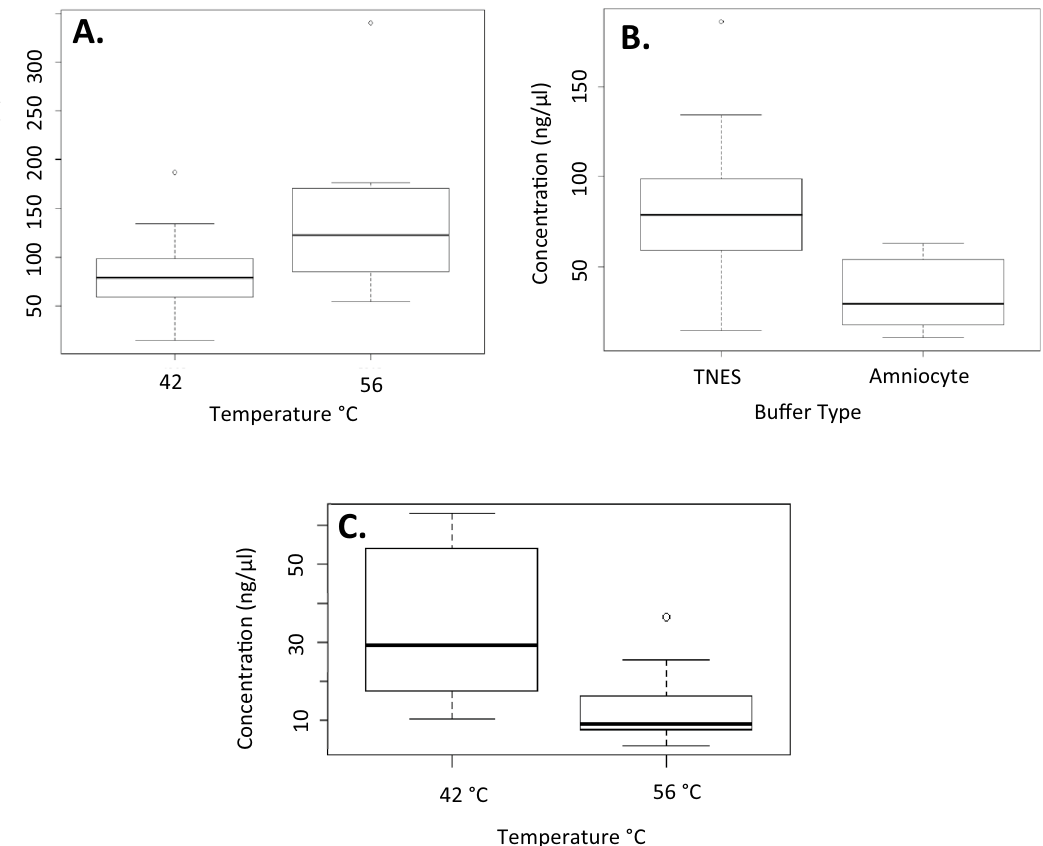
Figure 2. Box plots of the concentration of DNA following extraction using the phenol/chloroform protocol with TNES-urea digestion buffer and overnight incubation at different temperatures ( A ). The concentration of DNA following DNA extraction using the phenol/chloroform protocol with different digestion buffers at 42 °C overnight incubation ( B ) and the concentration of DNA following extraction using the phenol/chloroform protocol with an amniocyte digestion buffer and overnight incubation at different temperatures ( C